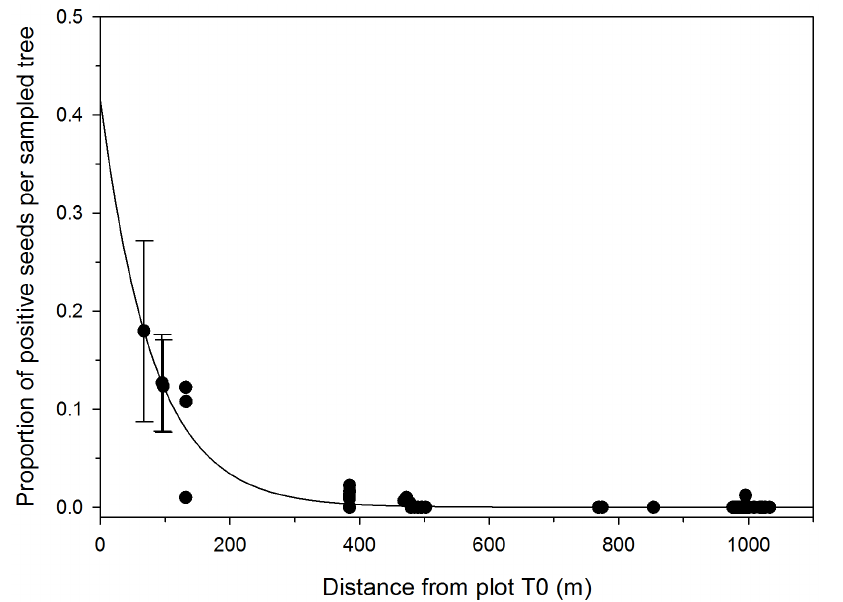
Figure 3. Estimates of the proportion of positive seeds per sampled tree for the 52 sampled tree locations outside of the GE plot (Plot T0) from 2000–2010, based on the fit of the exponential dispersal model to the data. Predictions and 95% prediction intervals are shown for the three tree locations surveyed in plot T0 (distances of 67, 95, and 97 m).